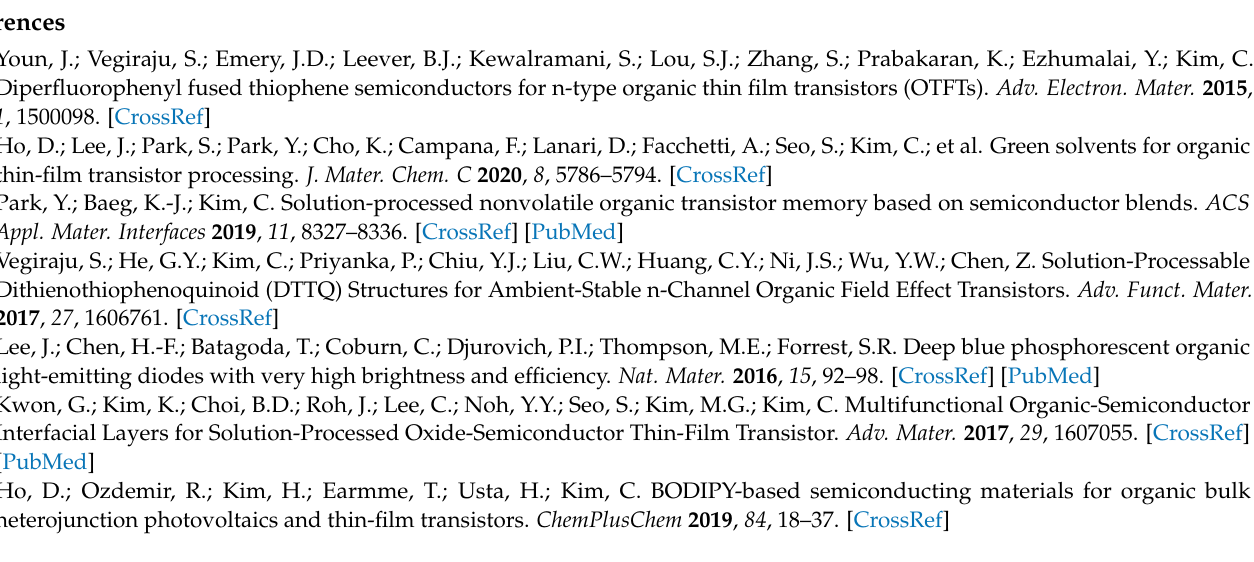
orbital surfaces of HOMO and LUMO by DFT calculation of Compounds (a) 1 , (b) 2 , and (c) 3 ; Figure S5: XRD profiles and AFM topographic images of solution-sheared film for (a) Compound 2 and (b) Compound 3 ; Figure S6: Representative transfer characteristics of OFETs based on (a) Compound 2 and (b) Compound 3 ; Figure S7: Transfer curve of OFETs based on Compound 1 after 30 days of device